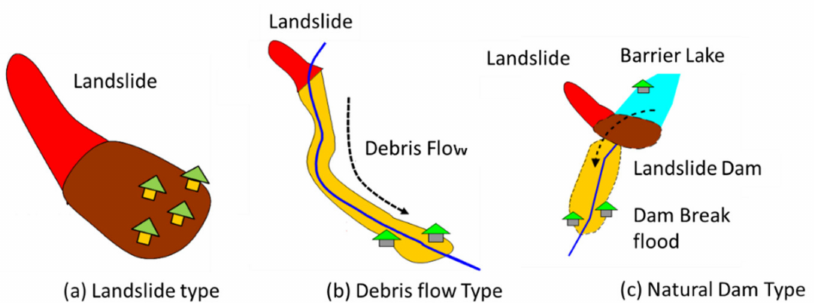
Figure 3. Disaster caused by large-scale landslides (modified from Kambara et al., 2014). ( a ) Landslide type: The material runs into a plane or mild slope (without any topographical restriction); ( b ) Debris flow type: The material runs into a river. The river topography satisfies the occurrence condition of debris flow; ( c ) Natural dam type: The material runs into a river. The river slope is mild. The volume of the material could block the river flow.